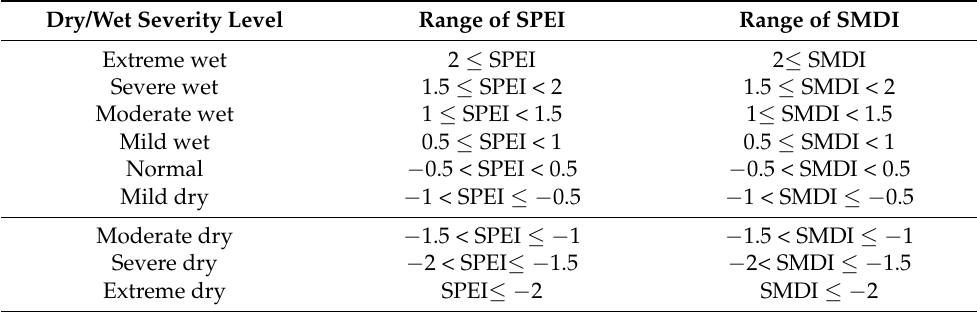
Table 2. Dry/wet condition classification based on SPEI and